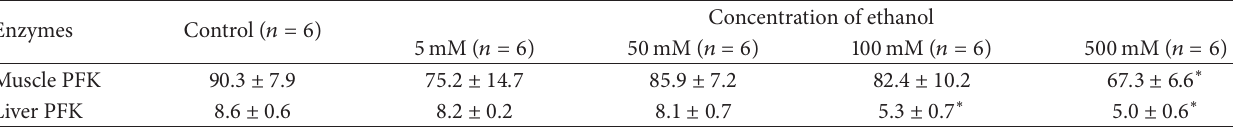
Significant ( 𝑃 < 0.05 ) differences with control group are shown by asterisks ( ∗